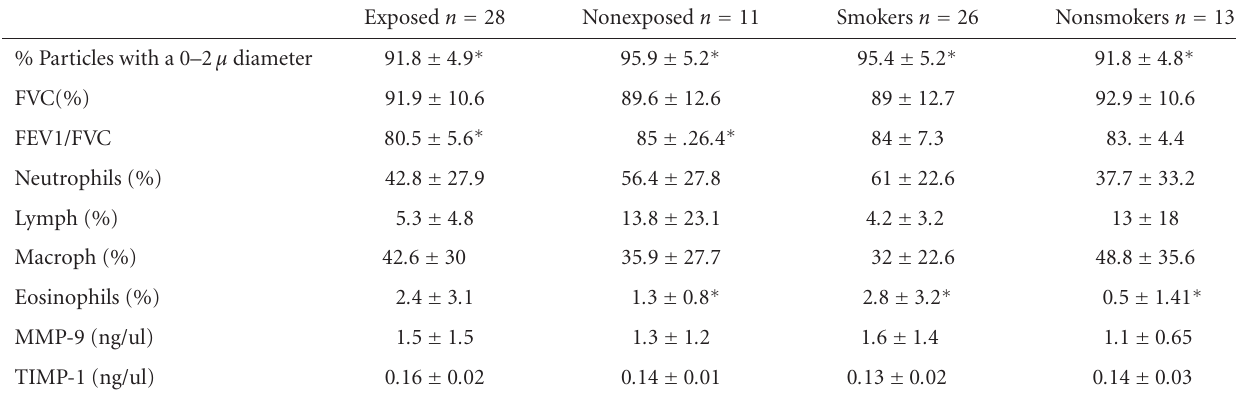
Table 2: A comparison of particles size, spirometry parameters, MMP-9, and di ff erential cell counts between the exposed, nonexposed, smoker, and nonsmoker